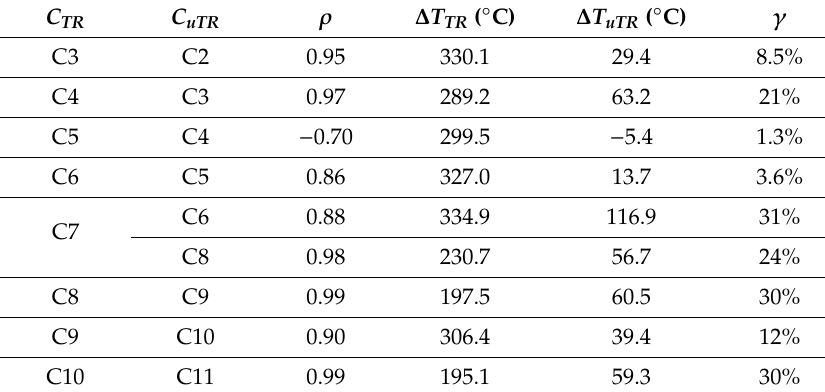
Table 8. Parameters of thermal runaway